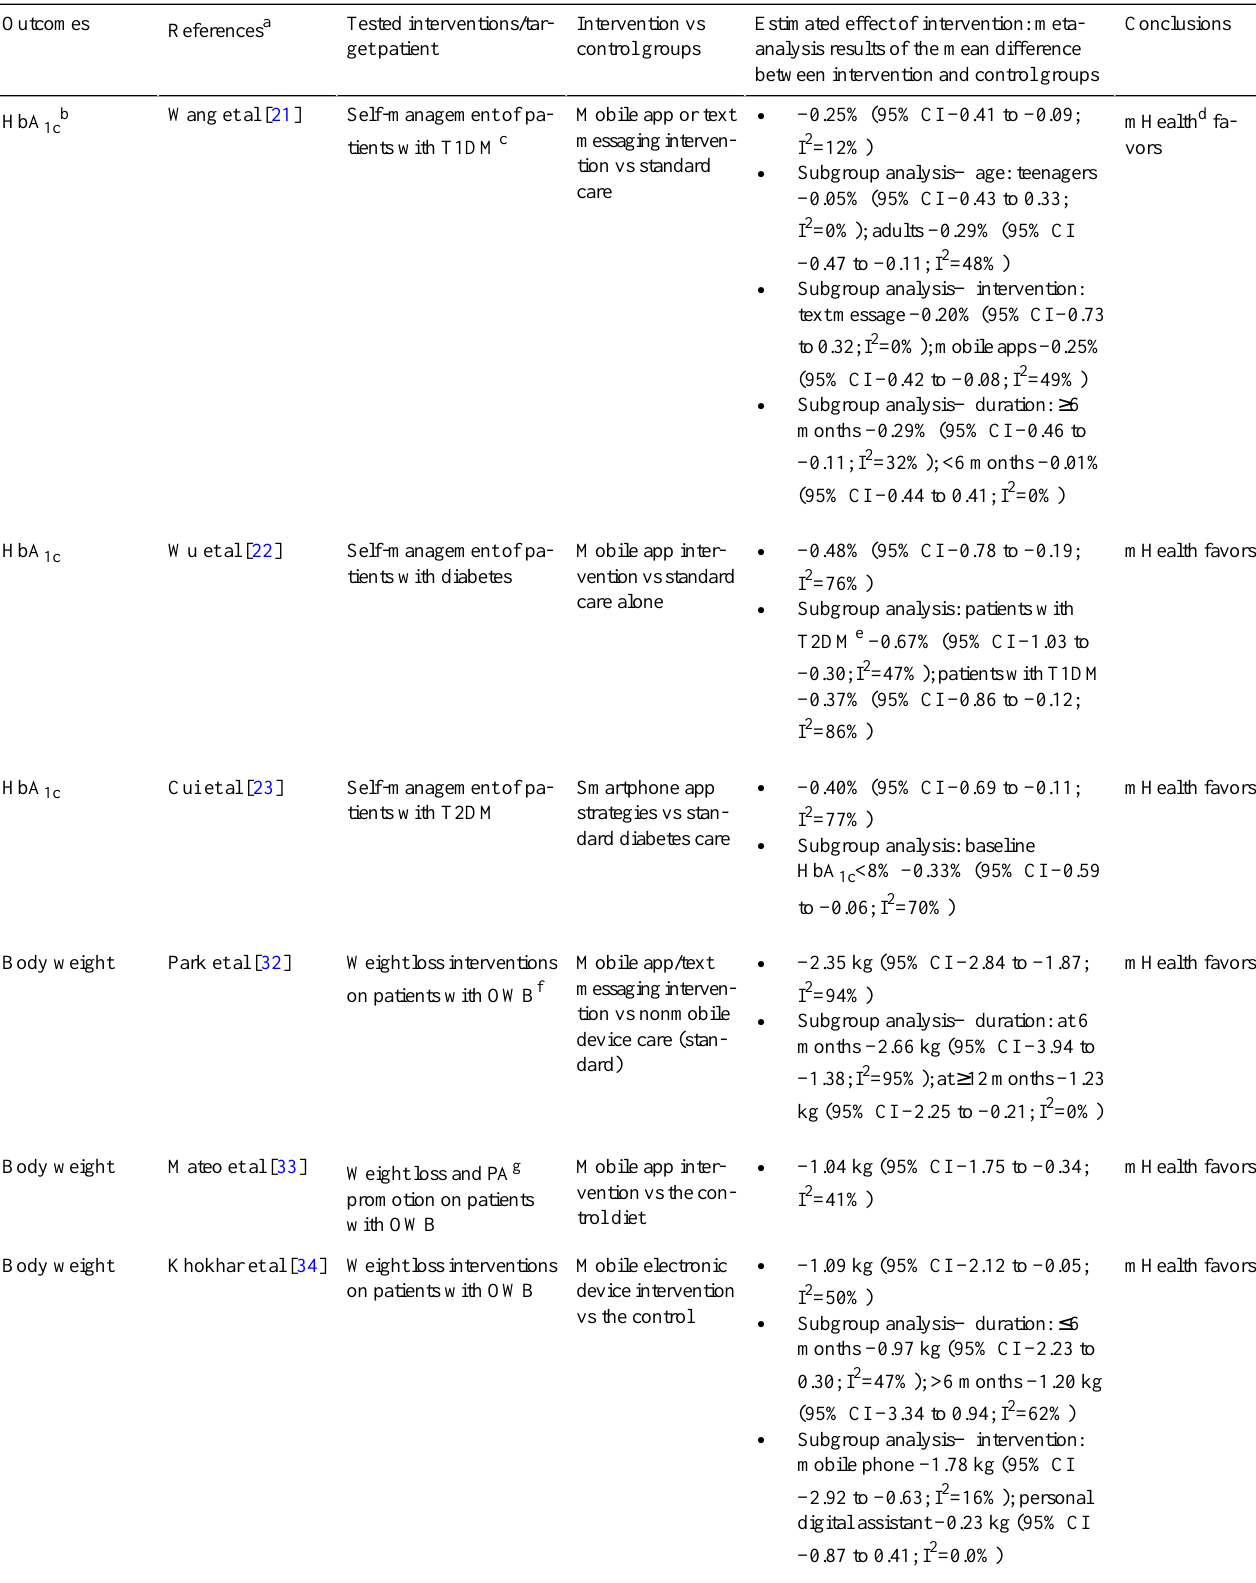
Table 1. Summary of clinical outcomes and behavioral changes from 18 meta-analyses reported in 6 reviews of diabetes and obesity mobile health interventions.